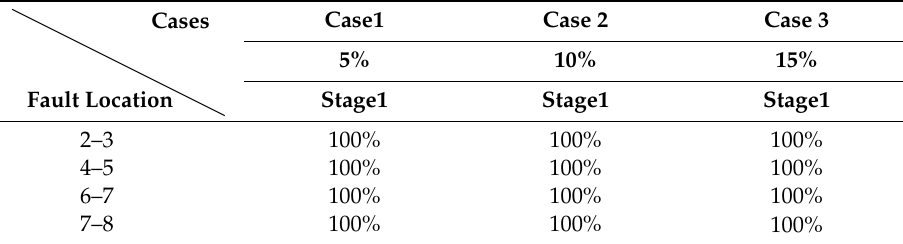
Table 5. Accuracy of the fault location according to load errors (fault in the main feeder).